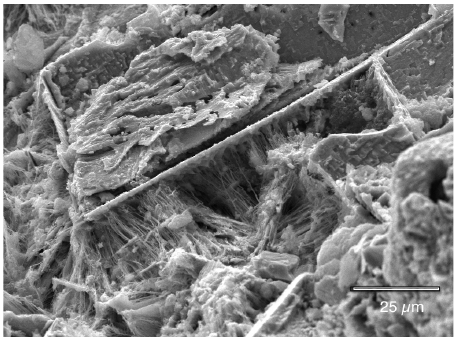
Figure 9. Microbial filaments deep inside a corrosion pit (hexamethyldisilazane (HMDS) fixation).